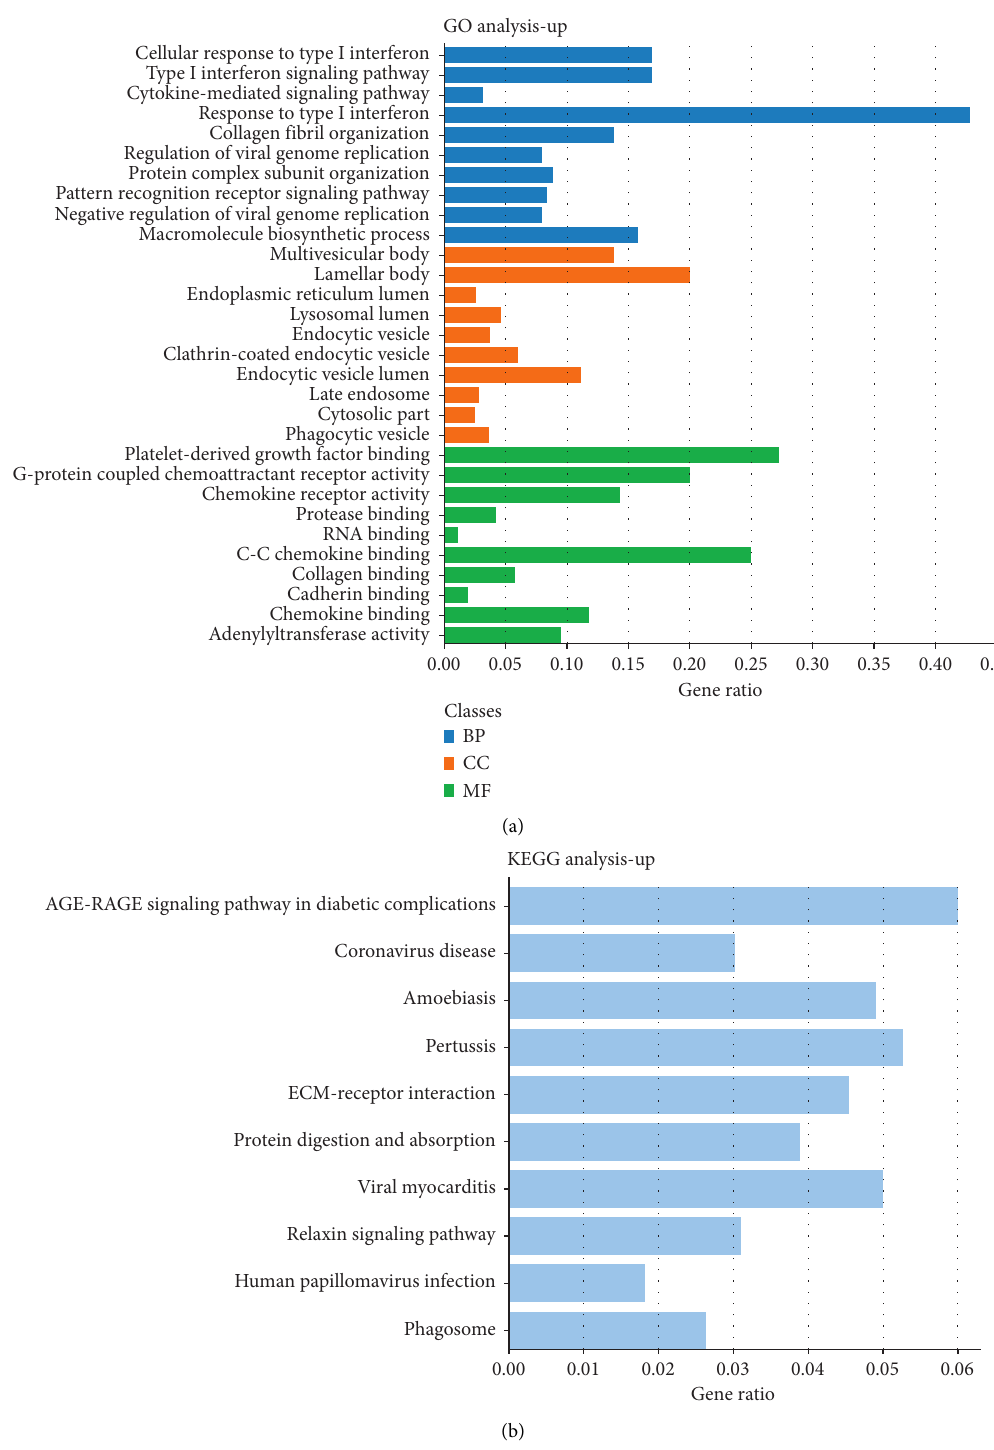
Figure 2: Upregulated DEGs’ analysis. (a) GO analysis. Blue represents BP, orange represents CC, and green represents MF. (b) KEGG pathway enrichment